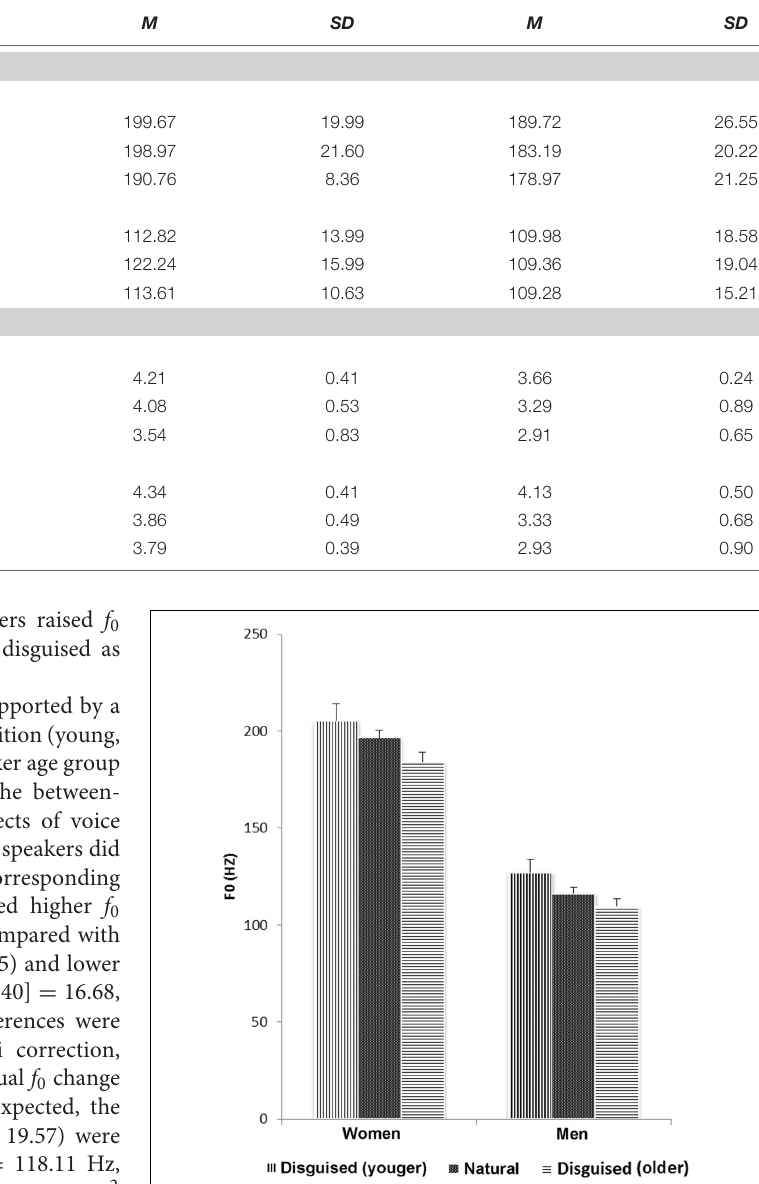
TABLE 1 | Mean and standard deviation of voice parameters for 18 female voices and 18 male voices over conditions and age groups in Study 1. Disguise (younger) Natural Disguise (older)